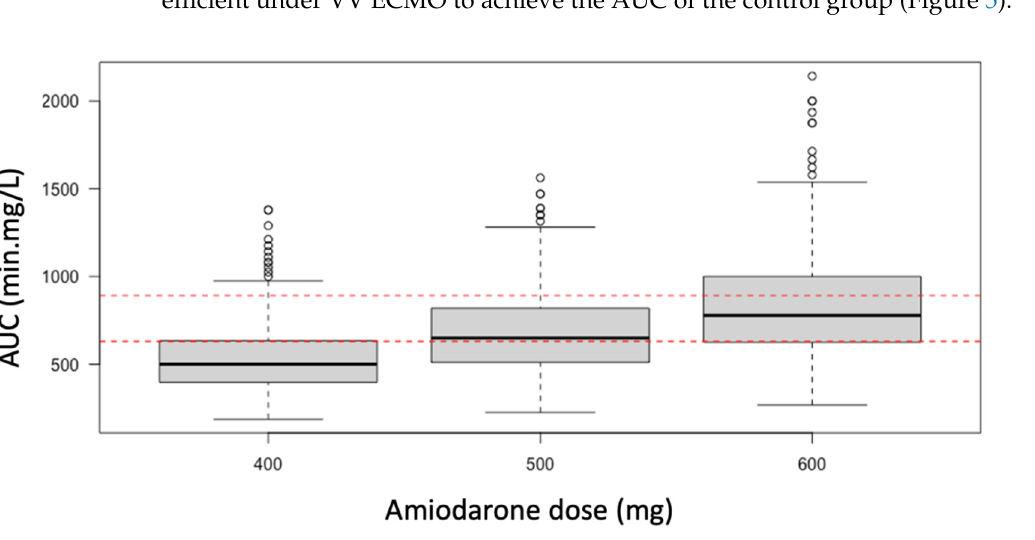
Figure 5. Simulated amiodarone exposure after administration of 400, 500 and 600 mg of amiodarone hydrochloride in the VV ECMO group. AUC: area under curve. Red dashed lines: amiodarone AUC Q1–Q3 in the control group. According to the Monte Carlo simulation, amiodarone 600 mg is required under VV ECMO for achieving the AUC control group.